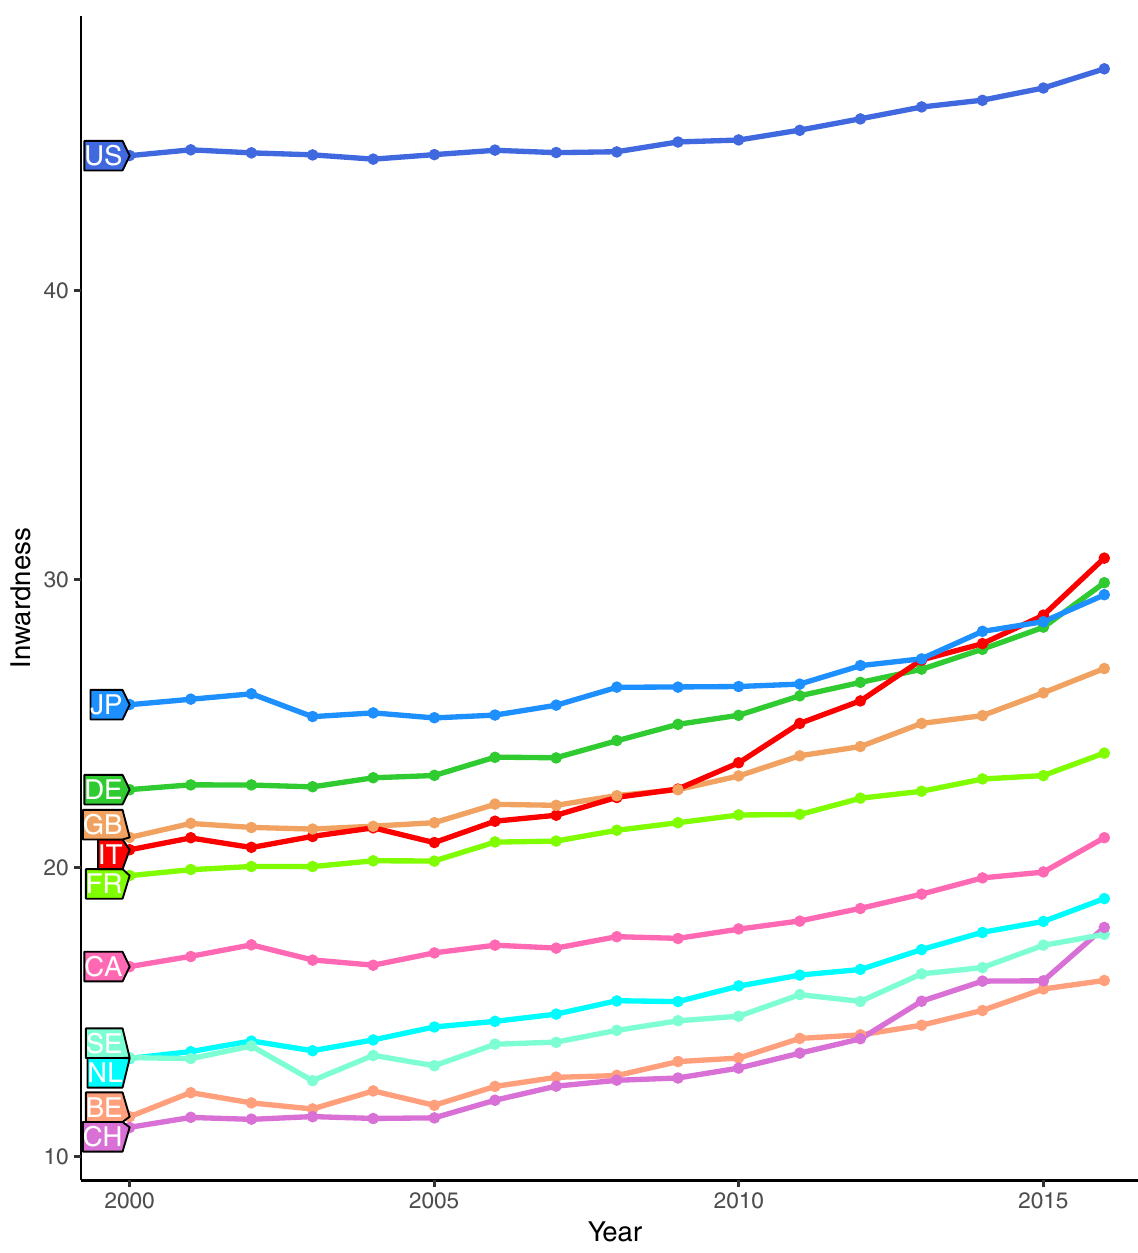
Fig 1. Inwardness for G10 countries (2000-2016). Source: elaboration on SCIval data.